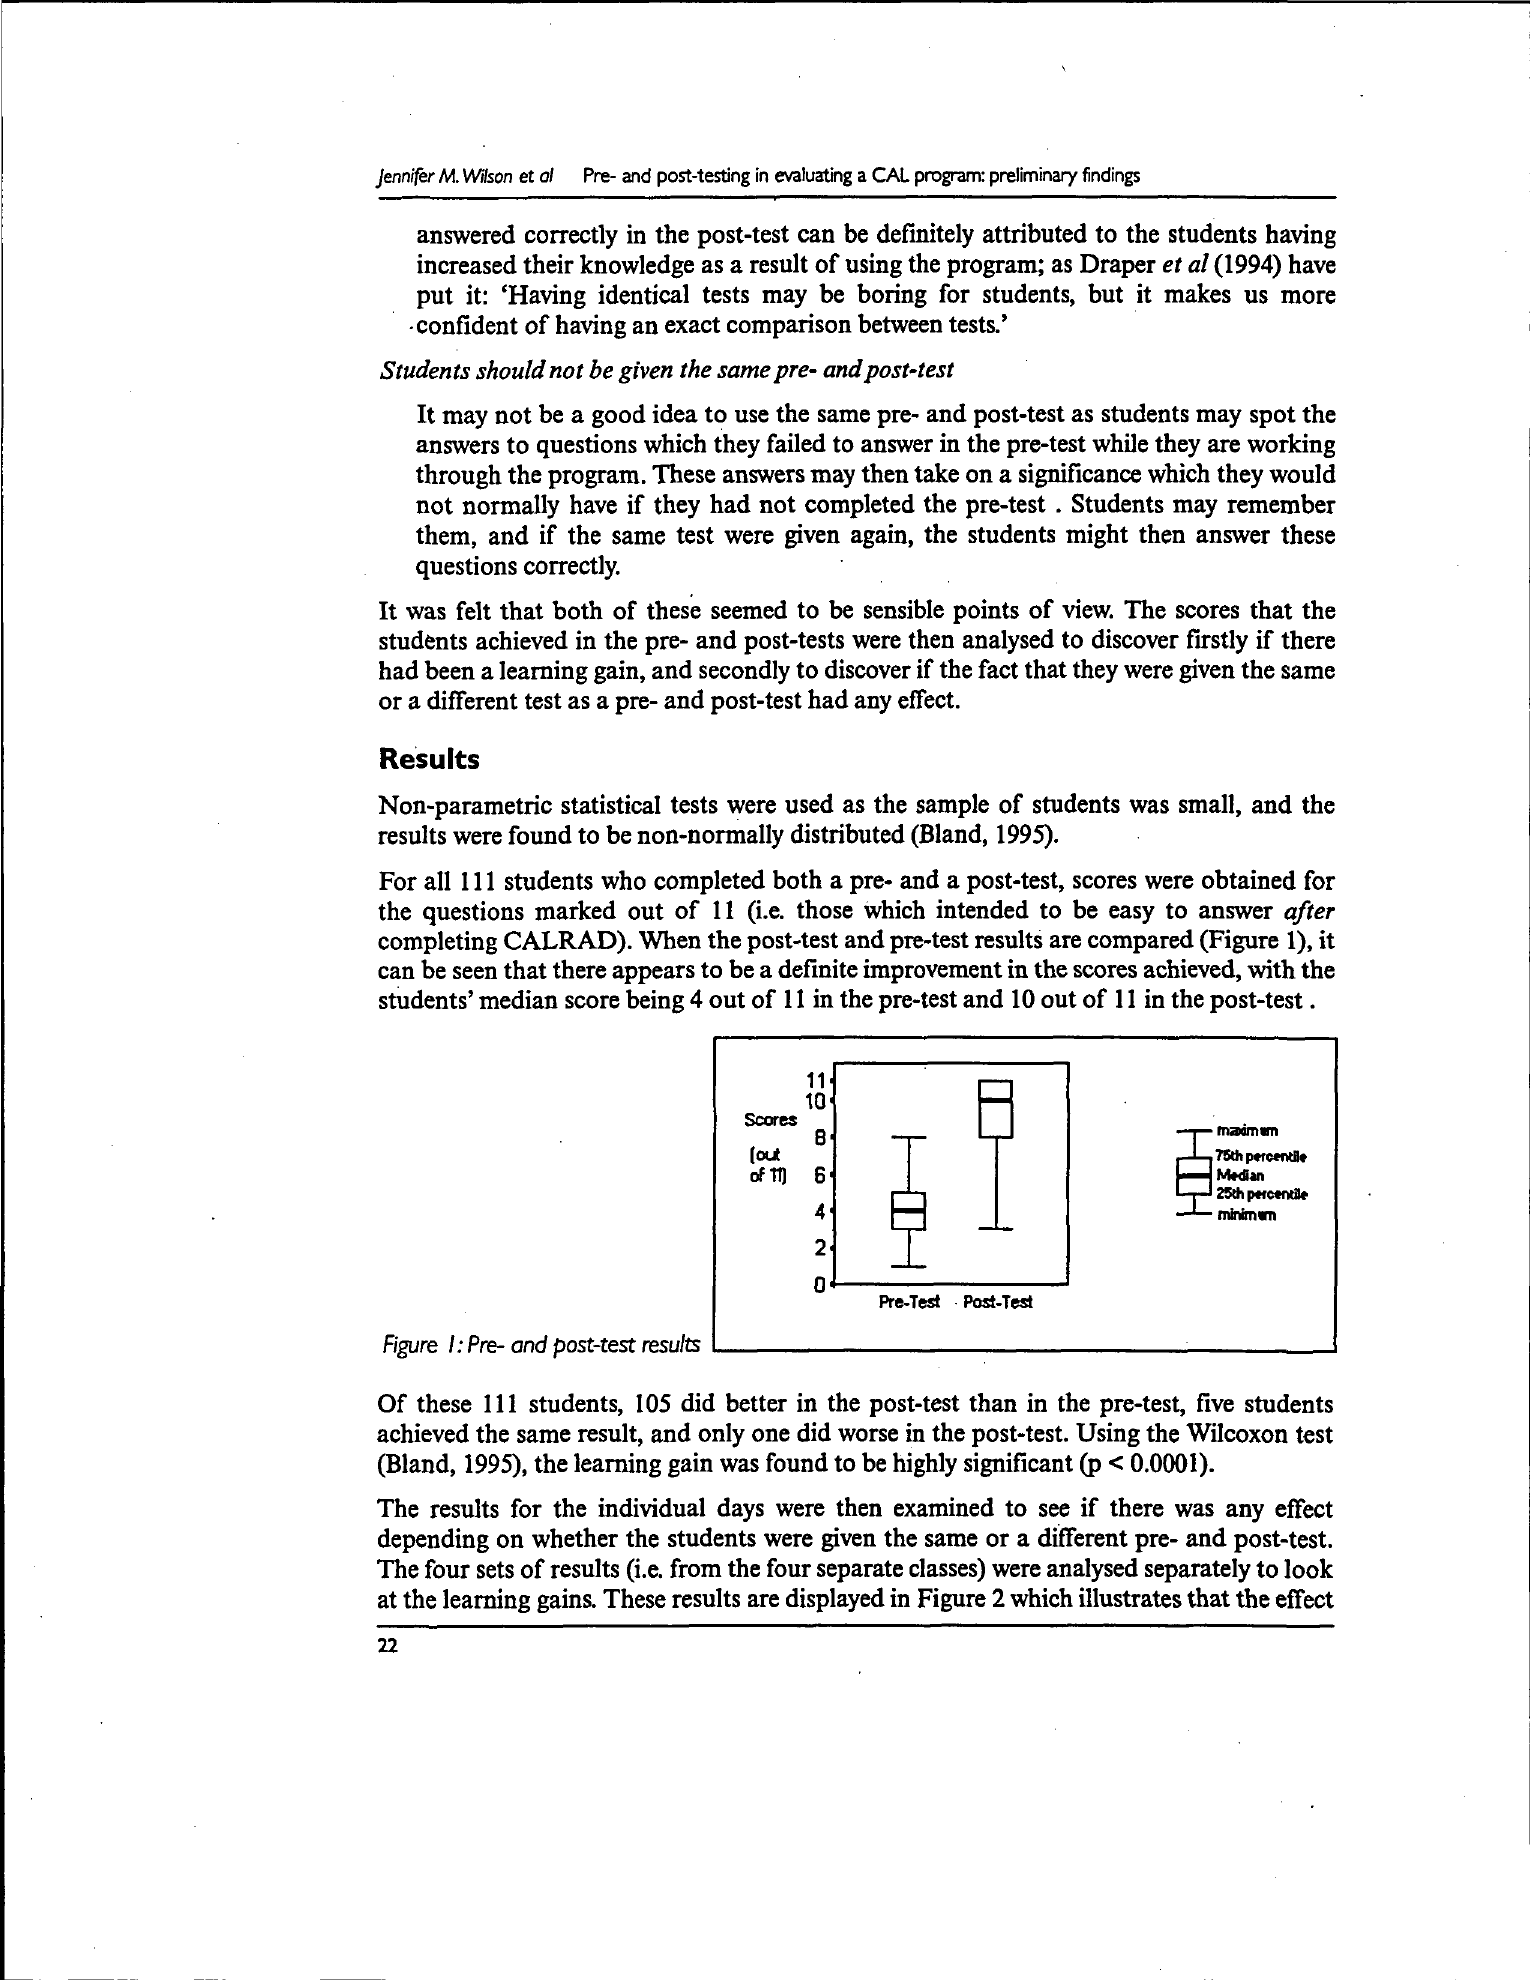
Figure I: Pre- and post-test